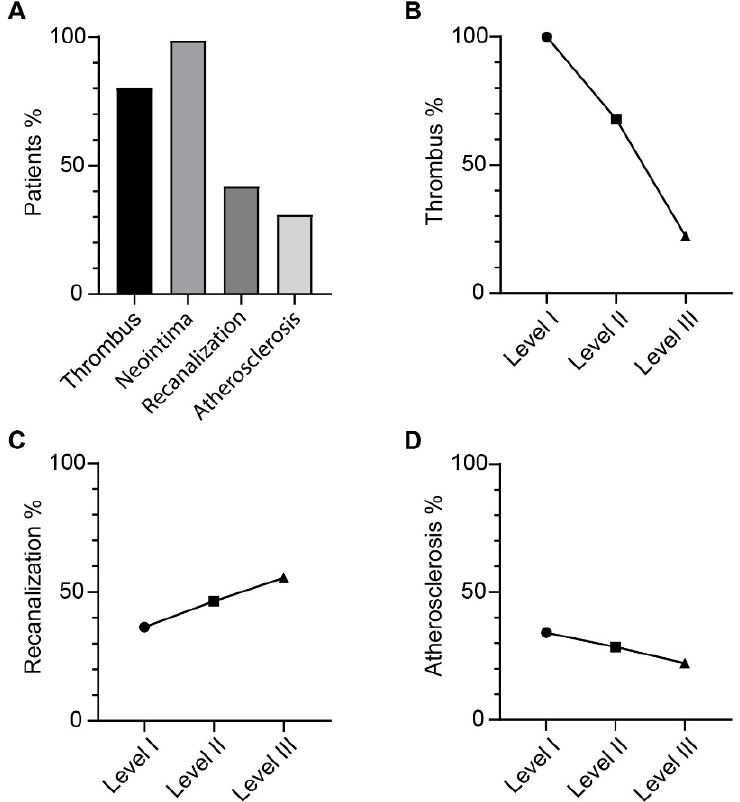
Figure 2. Distribution of different lesions in the CTEPH patient population. ( A ) Percentage of CTEPH patients with thrombotic, neointima, recanalized, and atherosclerotic lesions in PEA specimens. Repartition of patients with thrombus ( B ), recanalization ( C ), and atherosclerosis ( D ) formation based on UCSD surgical classification.